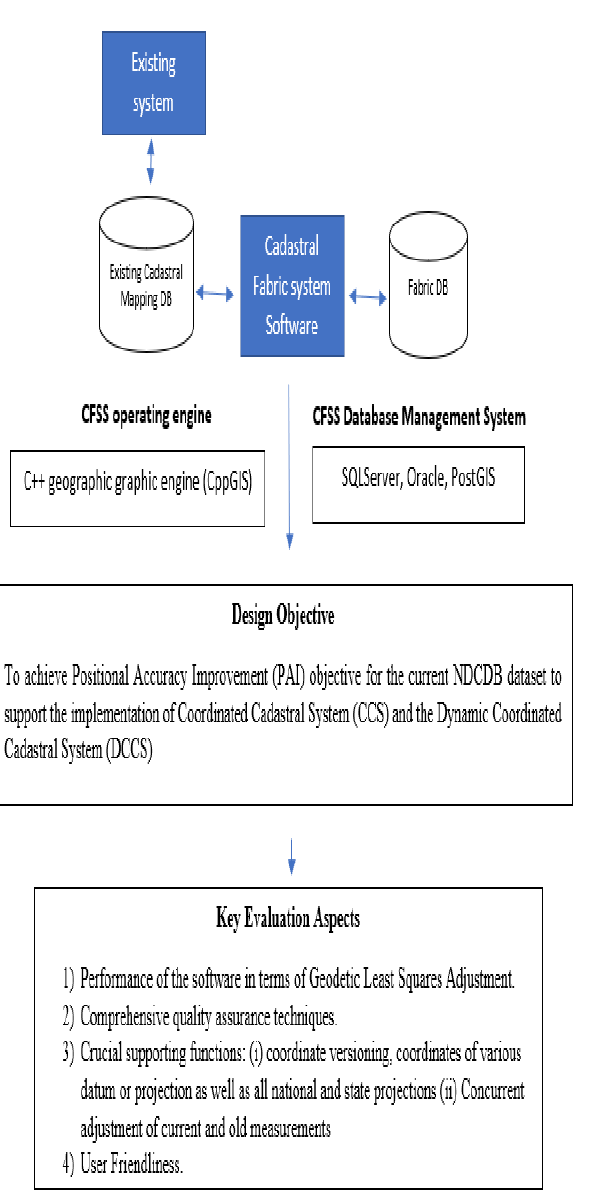
Figure 2 . Operational Framework